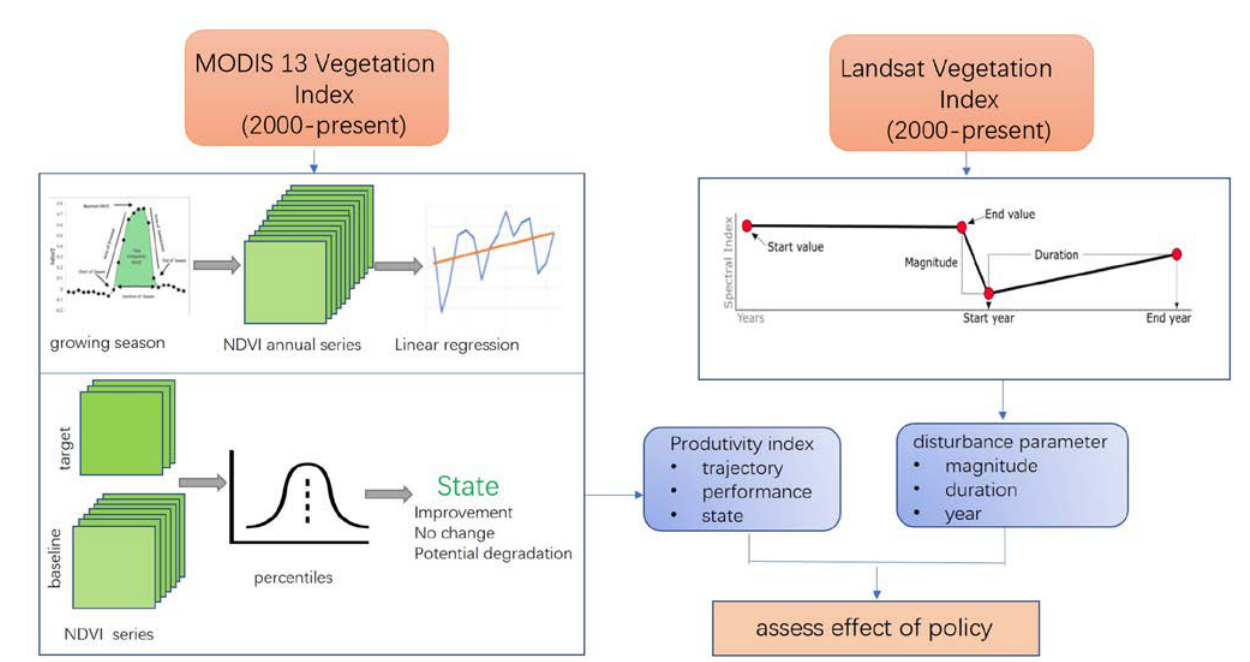
Figure 2. Scheme for calculating land productivity and disturbance for assessment effect of policy in Great Khingan Moun- tain (GKM), China.